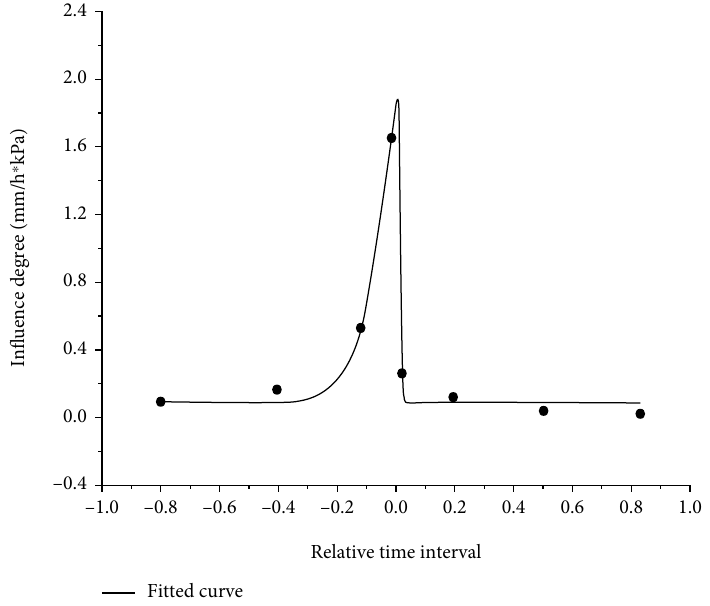
Figure 12: The relationship between in fl uence degree and relative time Table 3: Calculated results from empirical formula of landslide displacement.